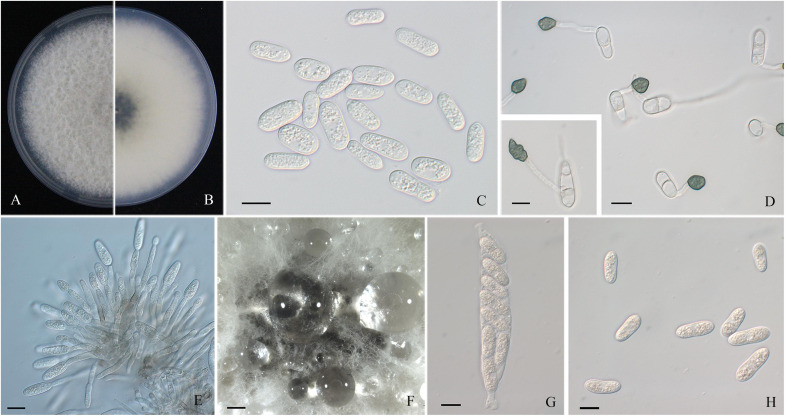
Morphological characters of Colletotrichum aenigma. (A,B) Front and back view, respectively, of 6-days-old PDA culture. (C) Conidia. (D) Appressoria. (E) Conidiophores. (F) Ascomata developed on PDA plates. (G) Asci. (H) Ascospores. Scale bars: (C–E,G,H) = 10 μm; (F) = 500 μm.